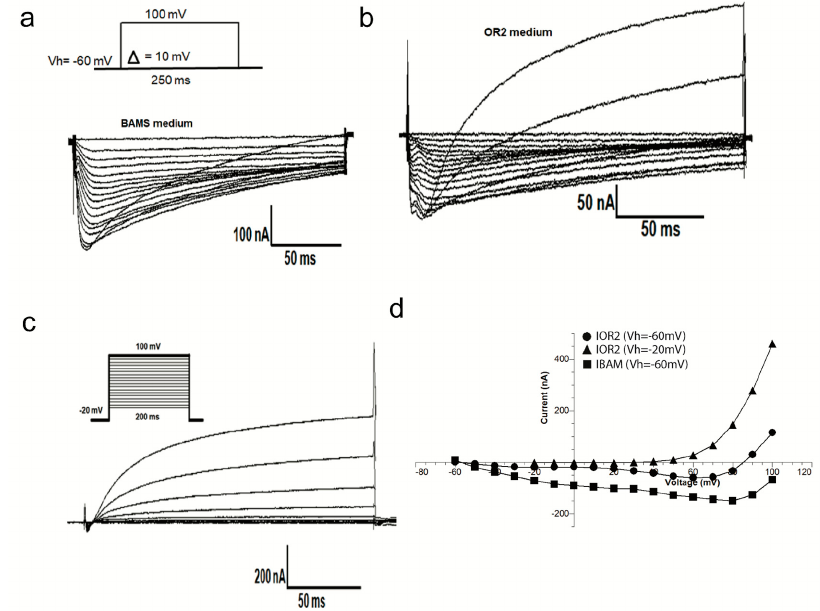
Figure 1. Xenopus oocytes current recordings obtained in different conditions of bathing media and holding potentials. The same oocyte was used for the experiments in each panel. Representative current traces of Xenopus oocytes held at − 60 mV in BAMS medium (Na + = 50 mM) ( a ), in OR 2 medium (Na + = 82.5 mM) ( b ), and in OR 2 medium at Vh = − 20 mV ( c ). Current-voltage relationships constructed using the current sizes of a, b and c families at different potential steps ( d ).